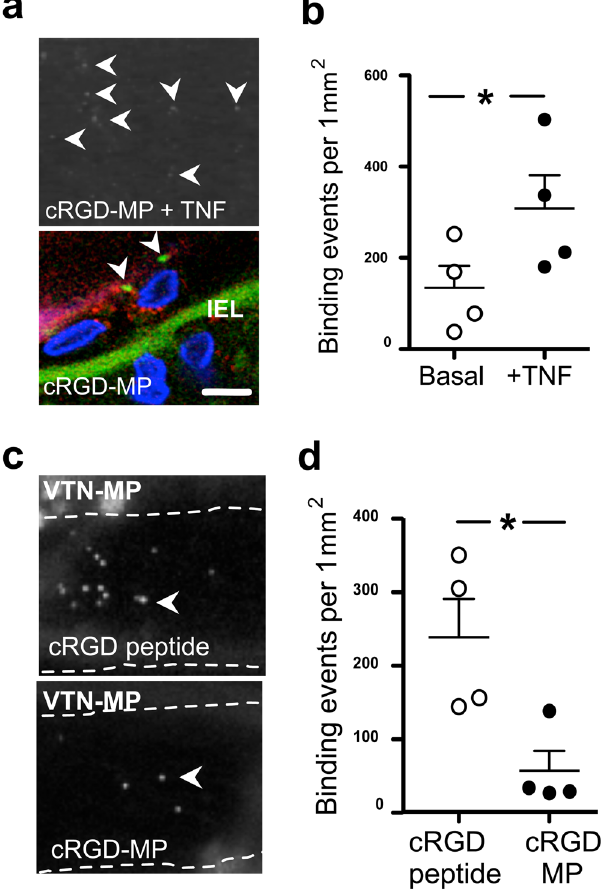
Figure 2. Modulation of RGD-endothelial interactions by microparticle-carried ligands. ( a ) Representative images show localization of cRGD-MPs (white arrowheads - upper panel; shown in green with arrowheads - lower panel) and CD-31 staining (red - lower panel) on TNF-activated endothelial cells (blue - DAPI). ( b ) Bindings of cRGD-MPs (0.1 µ g/ml) in isolated, pressurized MCA, before and after incubation with TNF. ( c ) Representative images show VTN-MP bindings in TNF-exposed MCA with prior intraluminal delivery of cRGD peptide (100 μ g/ml) or cRGD-MPs (0.1 µ g/ml). ( d ) Summary data of VTN-MP bindings in TNF-exposed MCA with cRGD peptide or cRGD-MPs. IEL: Internal Elastic Lamina. Scale bar: 10 μ m. Data are mean ± SEM; * p <